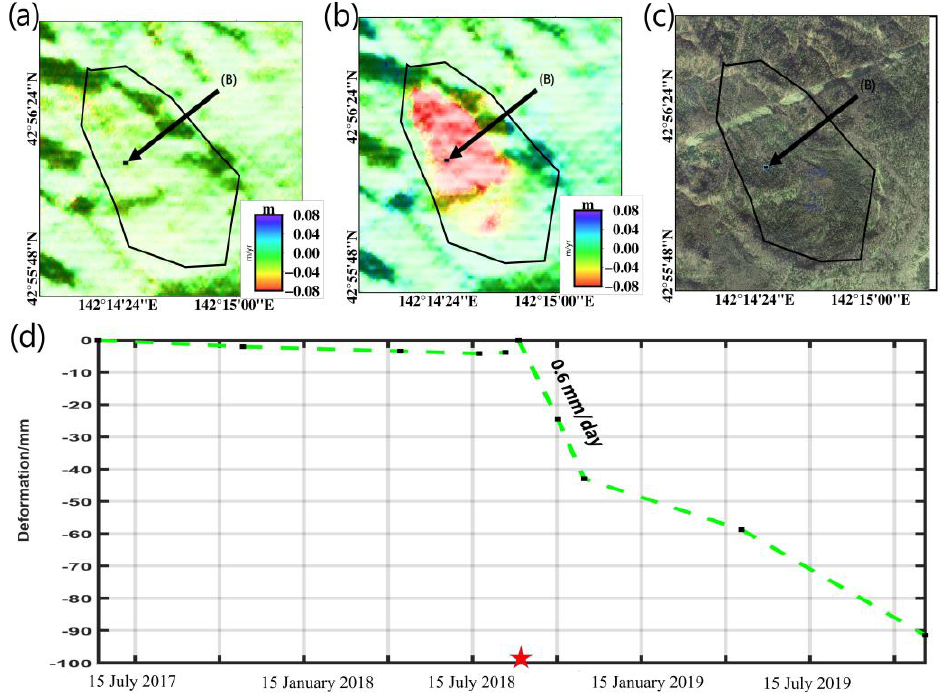
Figure 10. ( a , b ) Average LOS deformation velocities of landslide P8 before and after the earthquake, respectively. ( c ) Optical image of landslide P8. ( d ) Time series deformation of point B before and after the earthquake. The pentagram indicates the time of the earthquake.